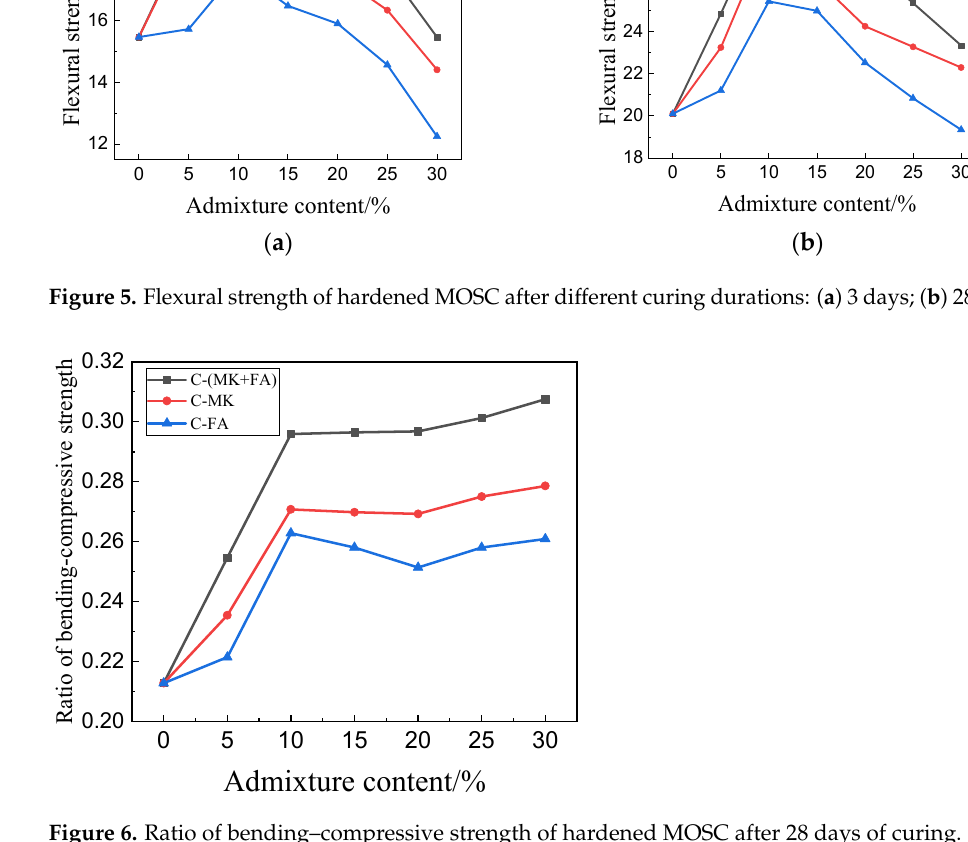
Figure 6. Ratio of bending–compressive strength of hardened MOSC after 28 days of curing.